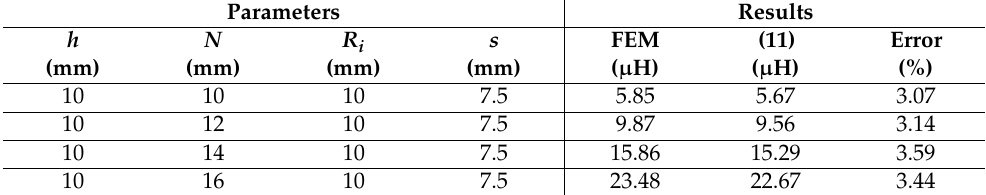
Table 3. Comparison result with variation in number of